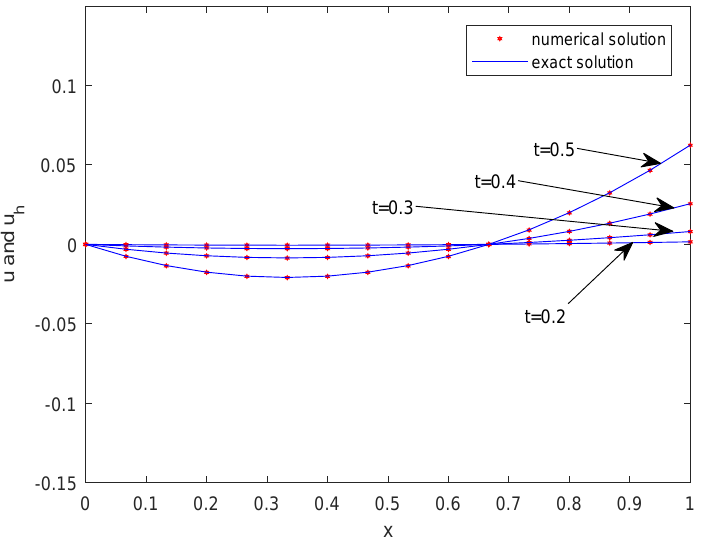
Figure 2. Comparison between u and u h at time t =